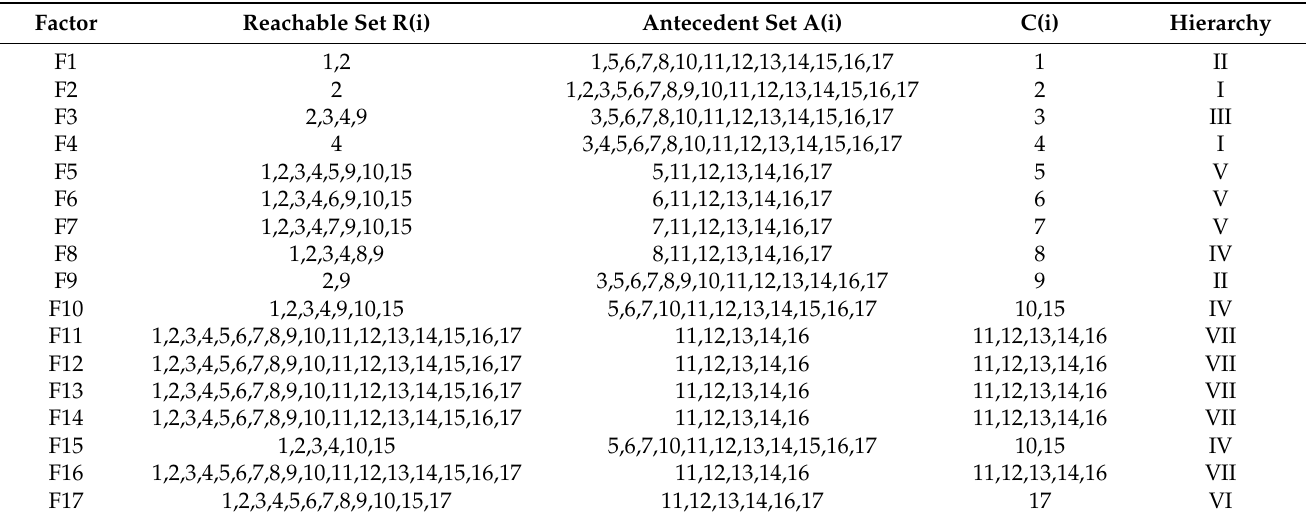
Table 3. Hierarchy of factors within